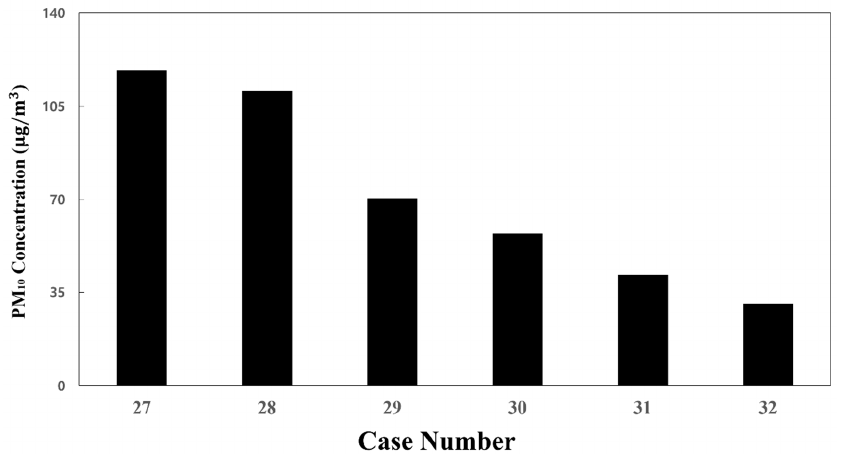
Figure 13. Average PM 10 concentration in the cabin at a fixed flow rate ratio of 20:20:60 (total ventilation flow rate of 600 CMH applied for cases 27, 29, and 31, 700 CMH—for cases 28, 30, and 32; filter efficiency of 70% applied for cases 27 and 28, 80%—for cases 29 and 30, 85%—for cases 31 and 32).